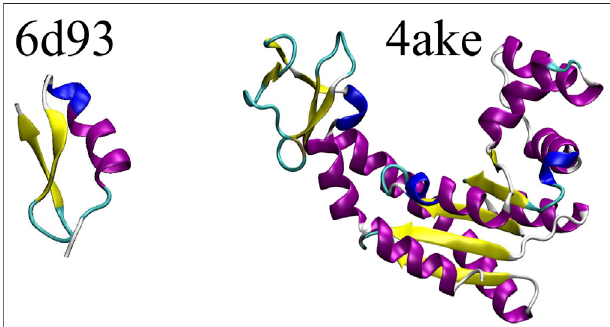
FIGURE 3 | Protein structures employed in this work: the tamapin mutant (PDB code: 6d93) and the open conformation of adenylate kinase (PDB code: 4ake). The former, although small, possesses all the elements of proteins ’ secondary structures,whilethe latterisbigger insizeand hasa much wider structural